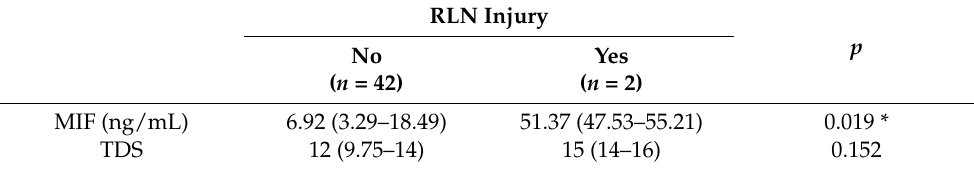
Table 3. Correlation between RLN injury and MIF or TDS.